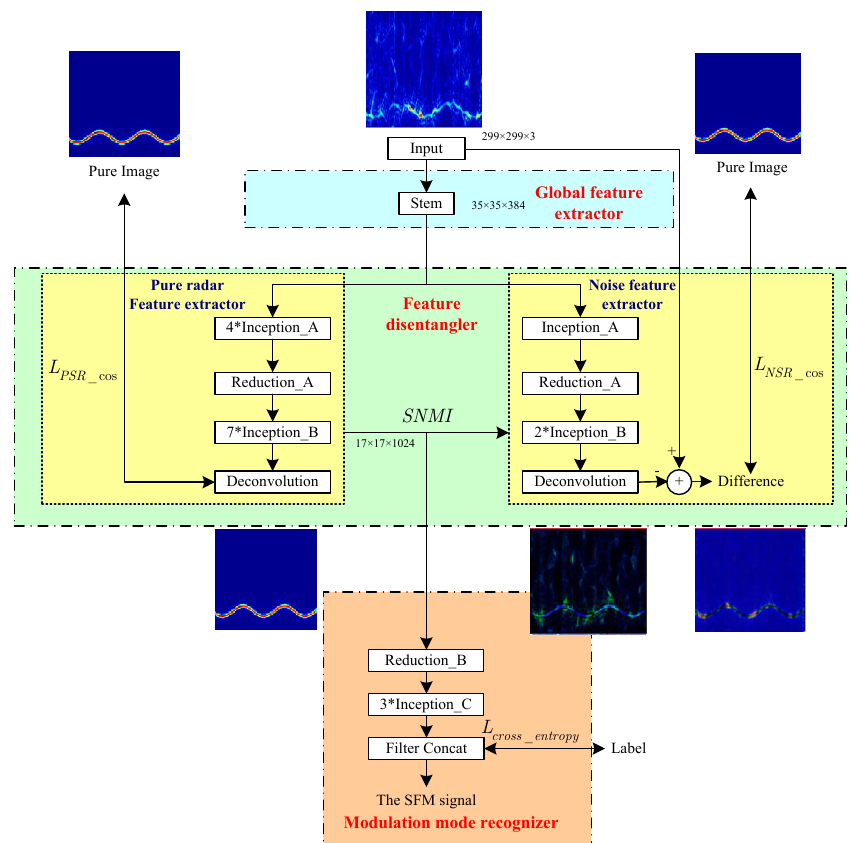
Figure 3. Detailed structure of the network.